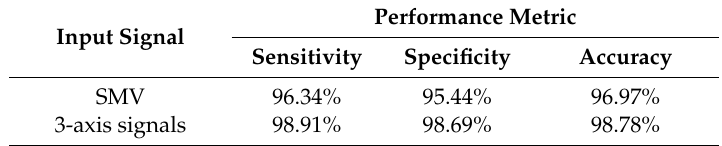
Table 6. Results of the detection system for the SisFall dataset (observation window T W = ± 2.5